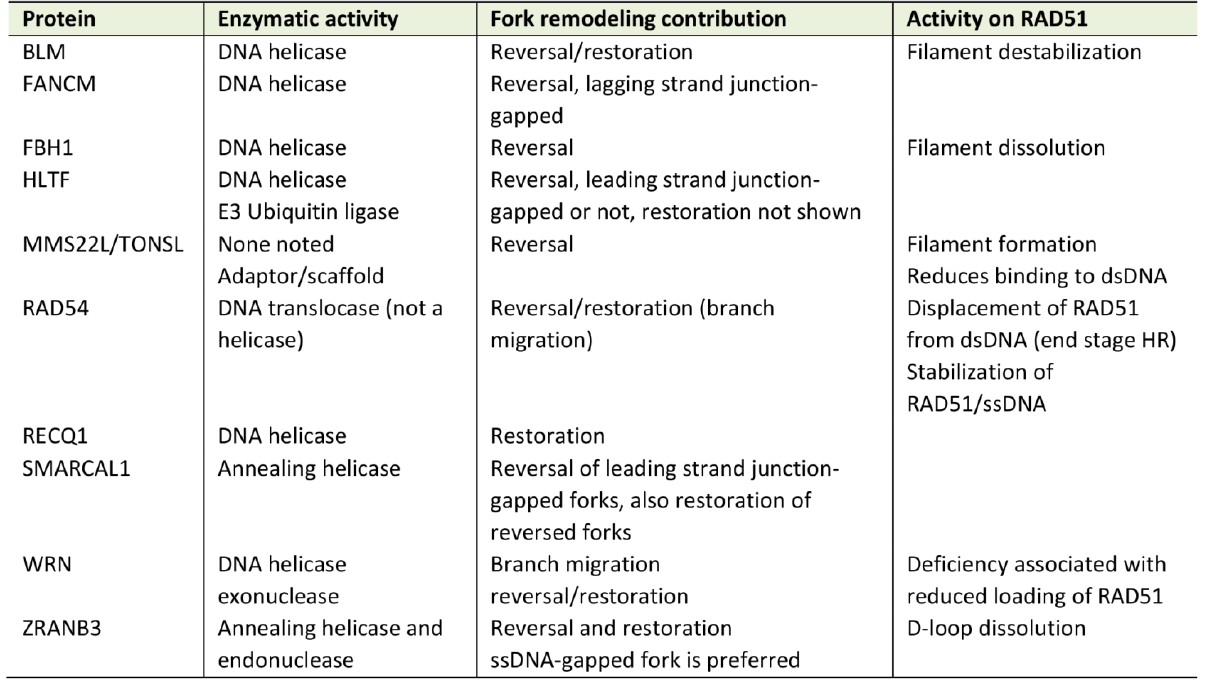
See main text for relevant